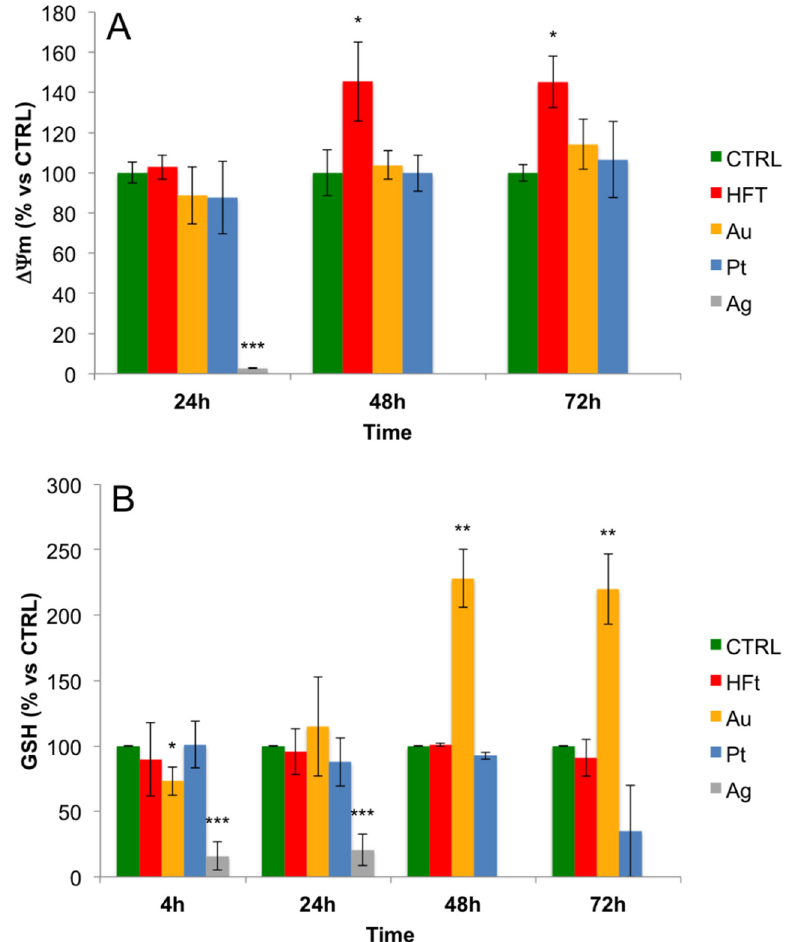
Figure 5. Mitochondrial potential ( A ) and glutathione (GSH) intracellular levels ( B ) of SH ‐ SY5Y cells upon treatment for the indicated time with 10 µ M nanocarriers, expressed as percentage of the control ± SD or SEM. Statistical significance assessed by t -test; * p ( t -test) < 0.05; ** p ( t -test) < 0.01; *** p ( t -test) <